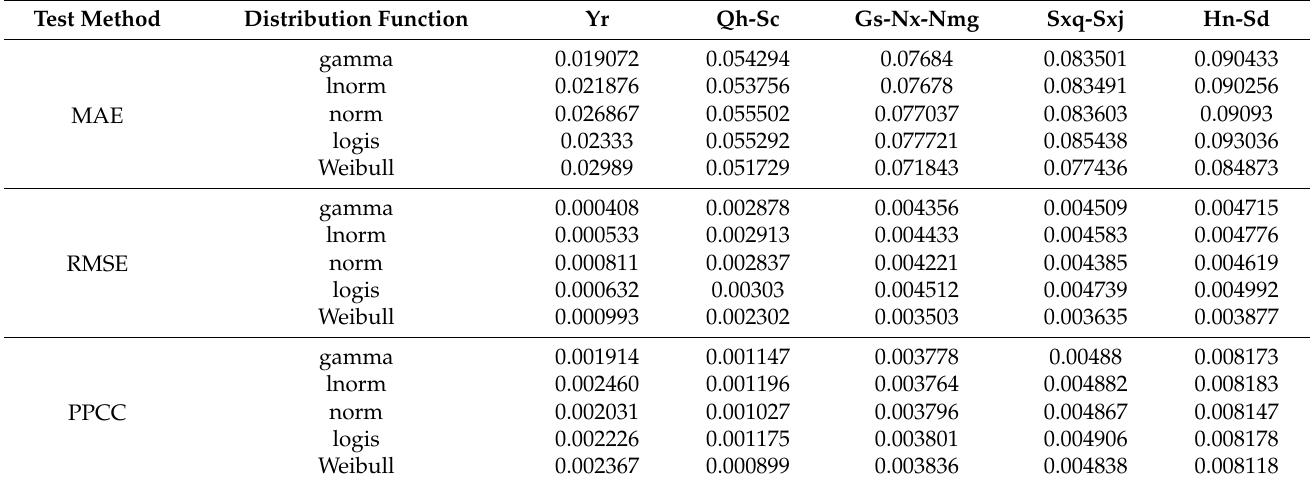
Figure 4. Correlation coefficient of precipitation among the nine provinces ( a ). Correlation coefficient of precipitation between Gs-Nx and other 7 provinces ( b ). Correlation coefficient of precipitation between Gs-Nx-Nmg and other 6 provinces ( c ). Correlation coefficient of precipitation among Gs-Nx-Nmg, Sxq-Sxj and other 4 provinces ( d ). Correlation coefficient of precipitation among Gs-Nx-Nmg, Sxq-Sxj, Hn-Sd and other 2 provinces ( e ). Correlation coefficient of precipitation among Qh-Sc, Gs-Nx-Nmg, Sxq-Sxj, and Hn-Sd ( f ).